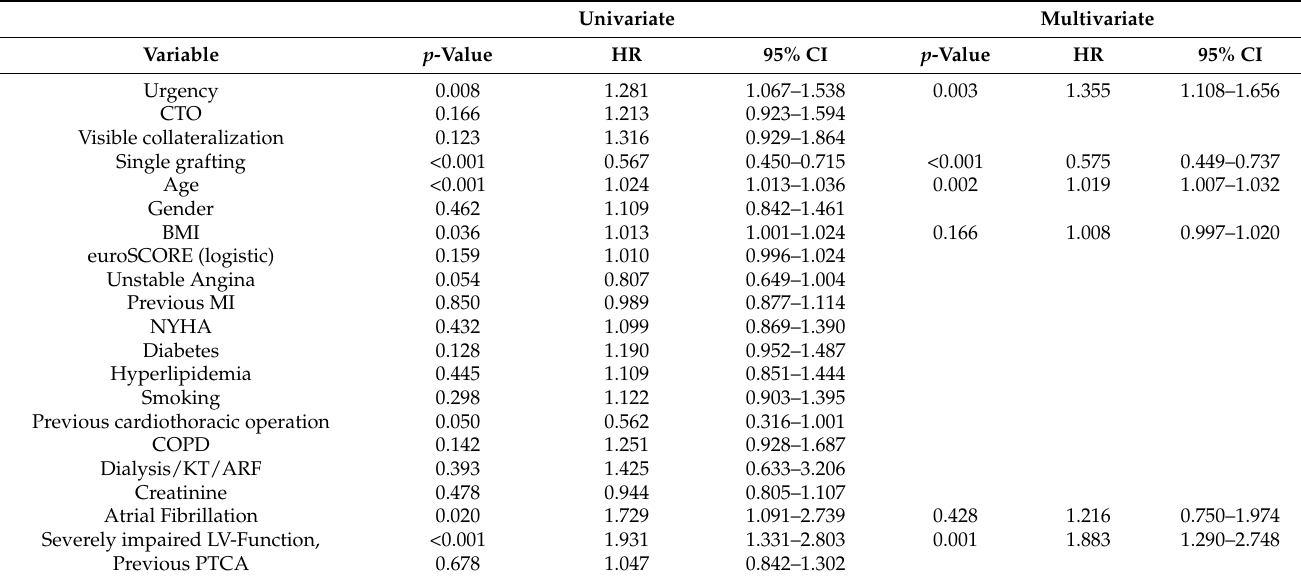
Table 3. Univariate/multivariate Cox regression analysis of the complete cohort (outcome variable: graft occlusion (yes/no)).